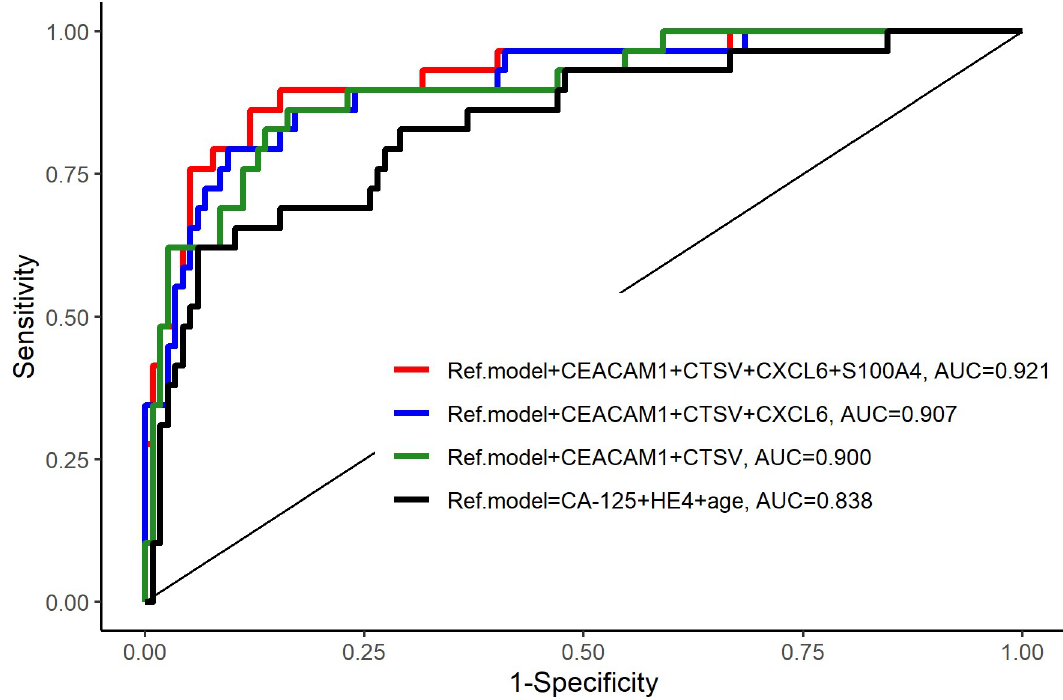
Fig 2. ROC curves for biomarker models. Benign tumors vs.